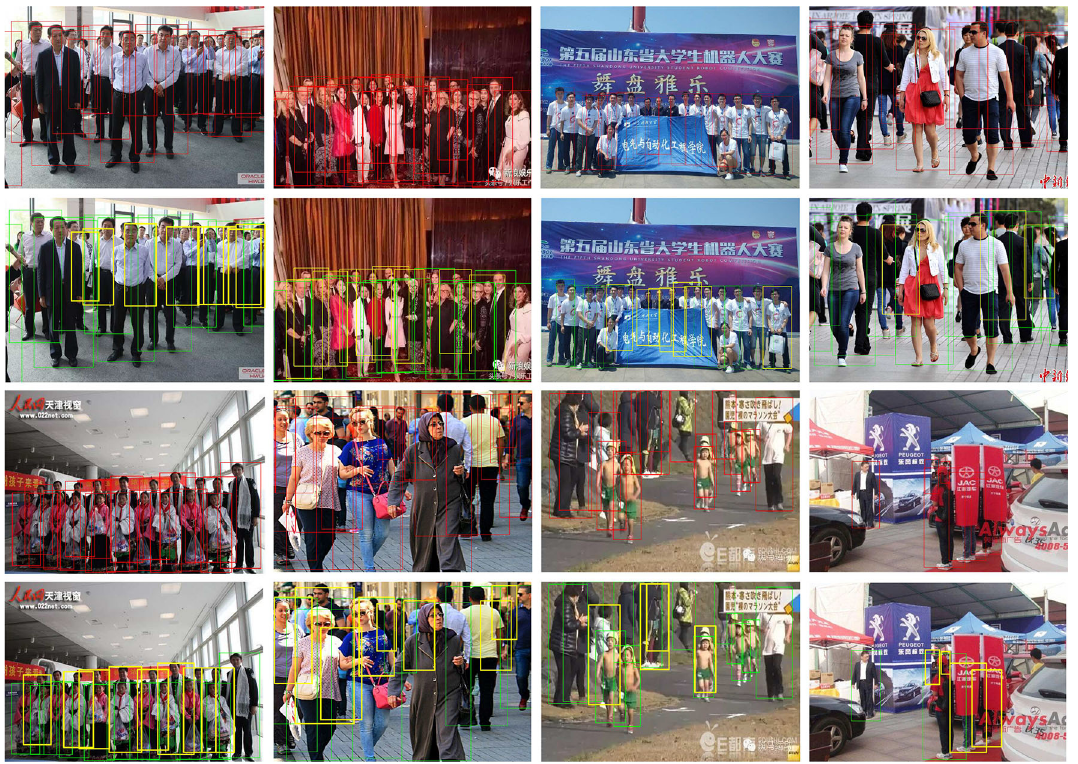
Fig. 7 The red boxes are prediction boxes generated by our YOLOC, the green boxes are the ground truth used in the evaluation codes, and the yellow boxes are the heavily occluded objects which are predicted by YOLOC properly but will be seen as false-positive ones during the evaluation process Table 5 Comparative results on